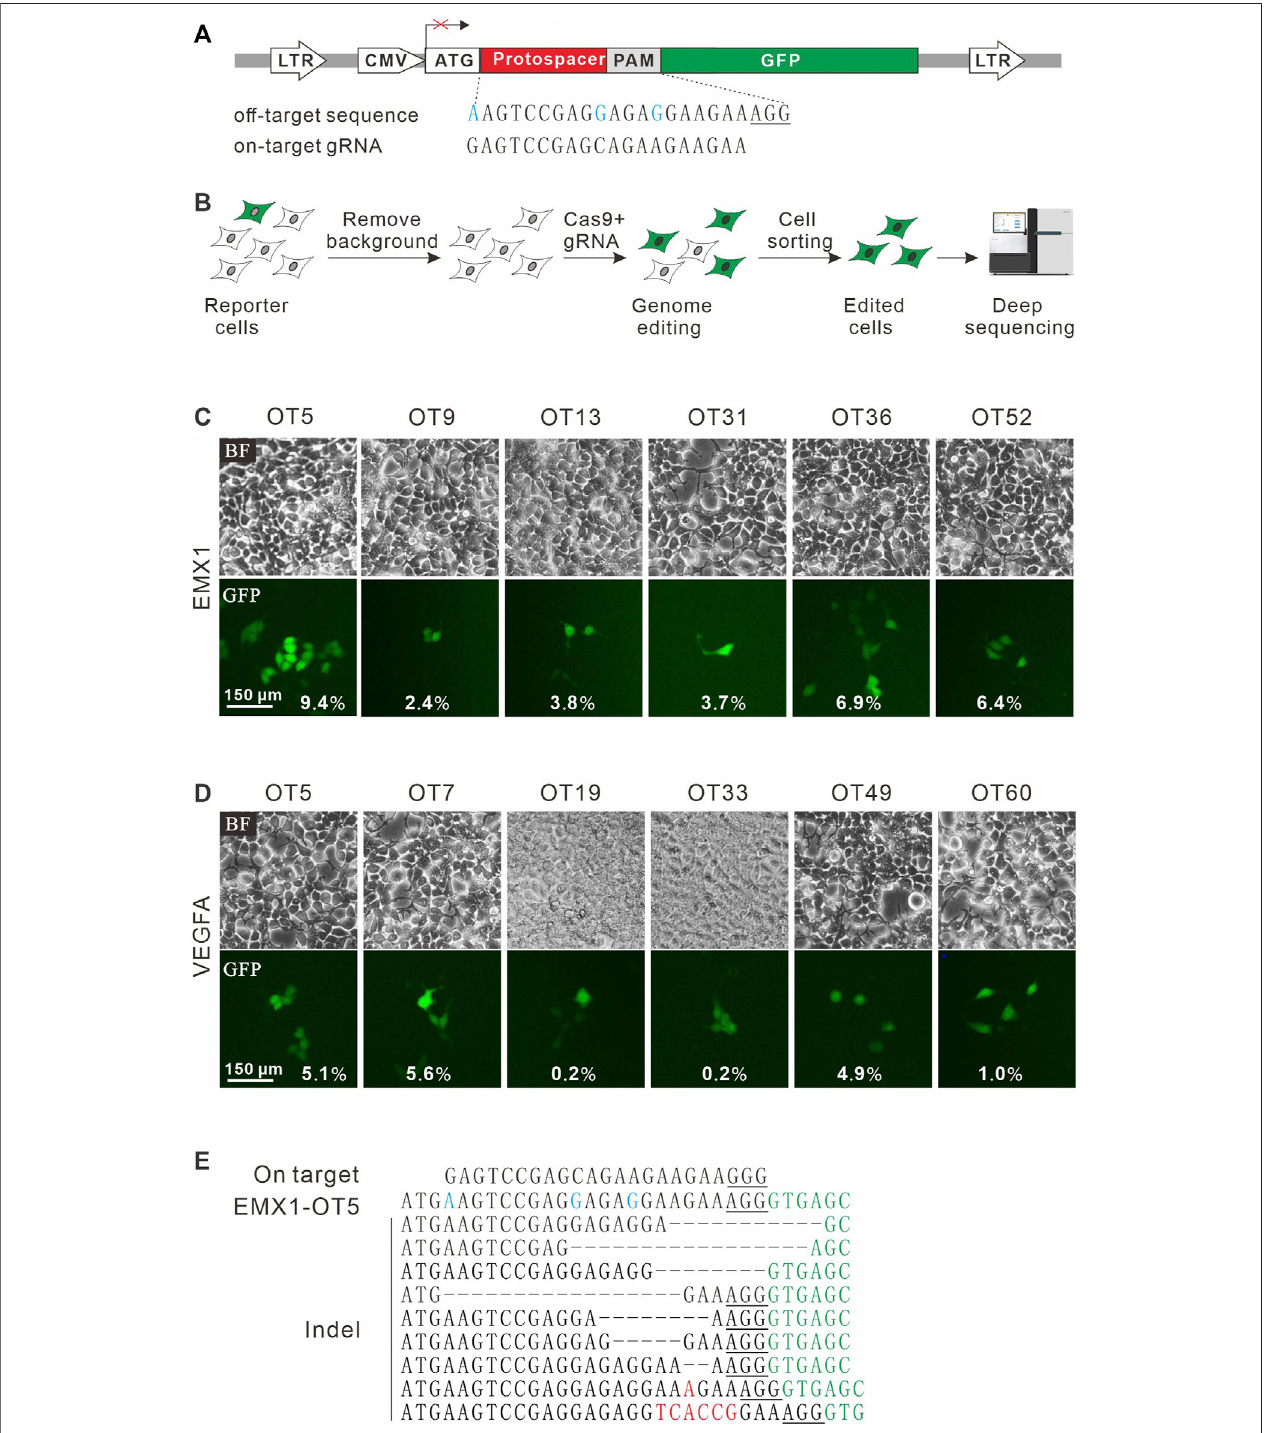
FIGURE1| AGFPactivationassayforDNAcleavagedetection. (A) SchematicdiagramoftheGFPactivationassay.AlentiviralvectorcontainsaCMV-drivenGFP. A protospacer followed by a PAM is inserted between ATG and GFP coding sequence, disrupting GFP expression. An example of off-target sequence as well as on- targetgRNA is shown below. (B) The vector isstably integratedinto HEK293T cells. Background GFP-positive cells areremoved by cellsorting. Aftergenomeediting,a portion of cells will restore GFP expression. GFP-positive cells are sorted out and PAM sequences were PCR-ampli fi ed for deep-sequencing analysis. (C) Six off- target sites (for a gRNA targeting EMX1 ) identi fi ed by CIRCLE-seq are selected for validation in cells by the GFP activation assay. (D) Six off-target sites (for a gRNA targeting VEGFA site1)identi fi edbyCIRCLE-seqareselectedforvalidationincellsbytheGFPactivationassay. (E) Indelsequencesaredetectedbydeepsequencingfor EMX1-OT5. On target sequence is shown above. Mismatches in the off-target sequence (EMX1-OT5) are shown in blue. The insertions are shown in red. The GFP sequence is shown in green. PAM is underlined.